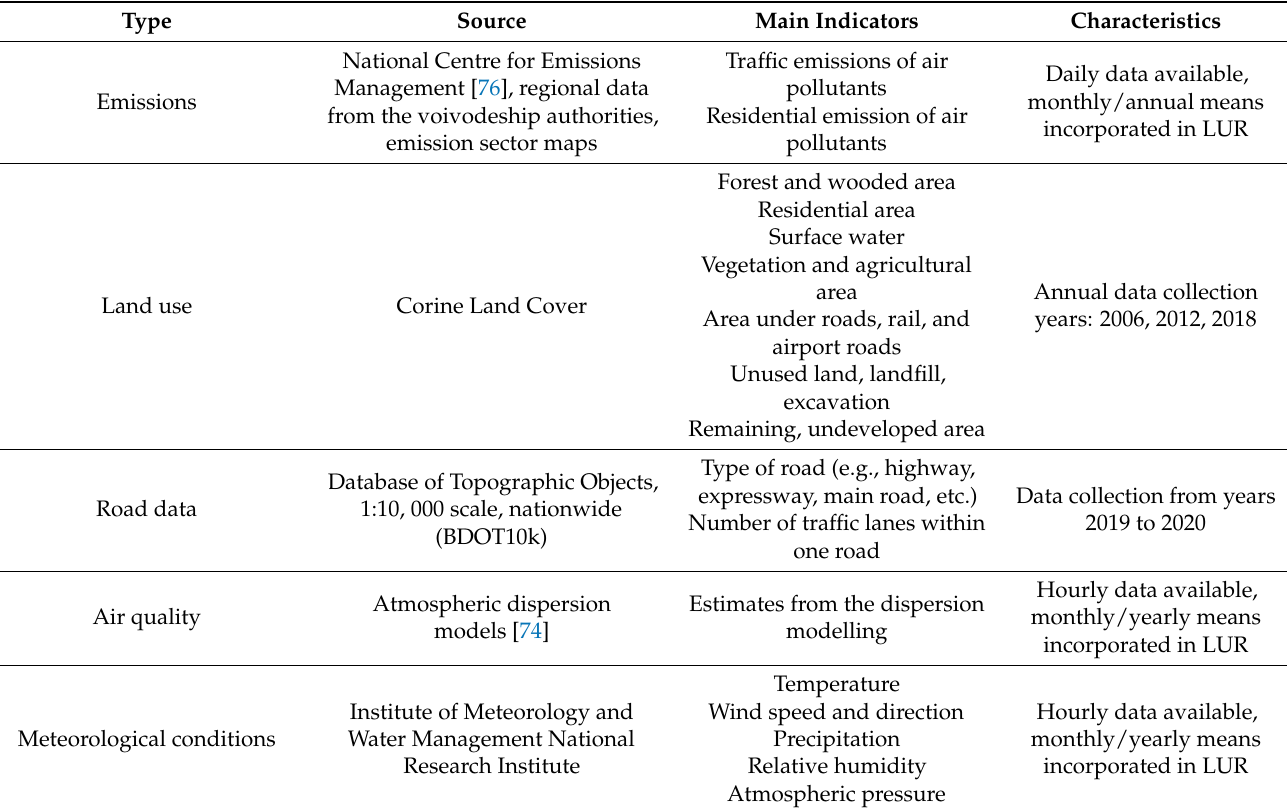
Figure 4. Boxplots illustrating annual means of daily measured NO 2 , PM 10 , and PM 2.5 air pollutants, grouped by type of station (urban, traffic, rural) from 2007 to 2019, based on monitoring stations in the study area. Between 2007 and 2019, the annual mean values of air pollutant concentrations at the monitoring stations ranged from 4.5 to 73.1 µ g/m 3 for NO 2 , from 11.2 to 80.9 µ g/m 3 for PM 10 , and from 16.1 to 61.1 µ g/m 3 for PM 2.5 . Table 3. Predictor variables for the air quality LUR